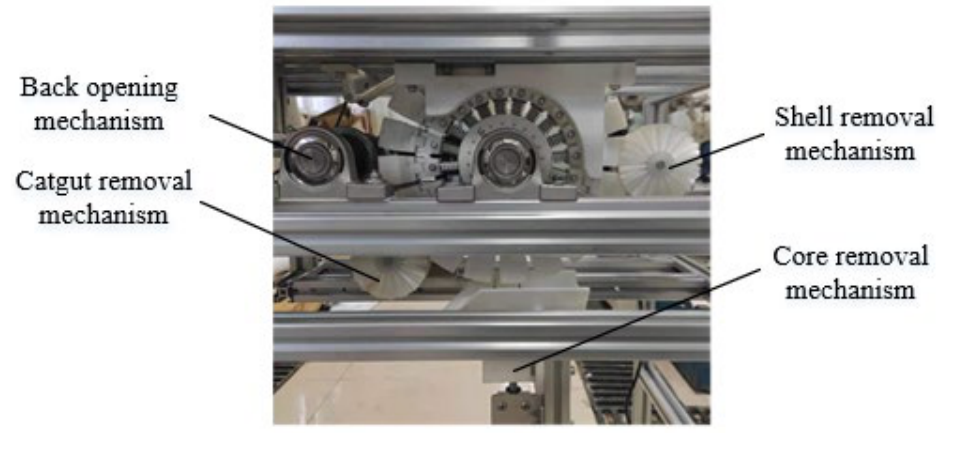
Figure 19. The shrimp directional peeling test device.